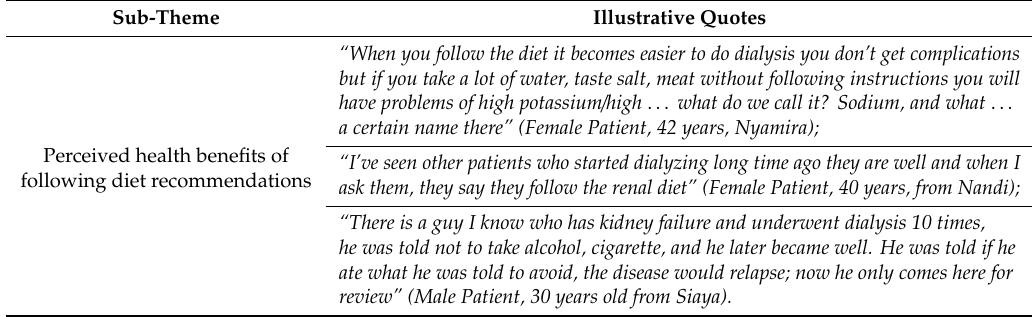
Table 1. Sub-theme 1—illustrative quotes on “perceived health